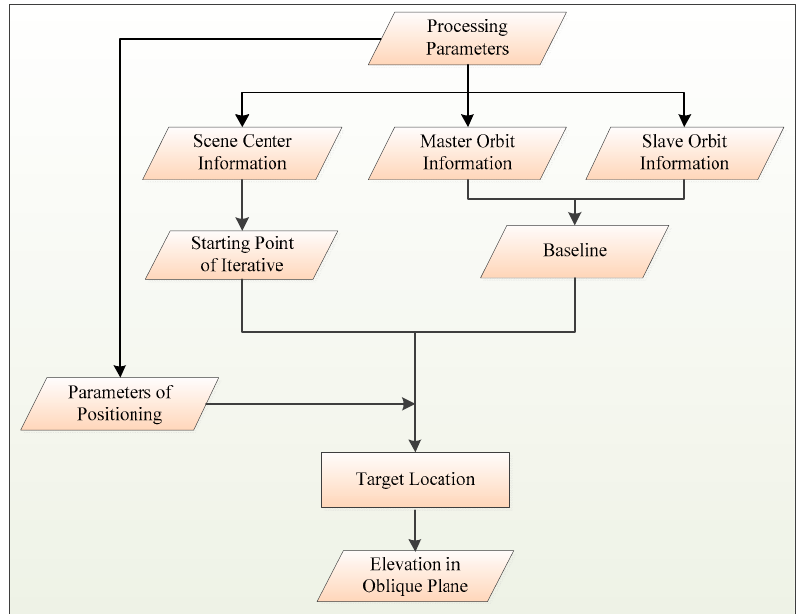
Figure 5. Target location by iterative method.